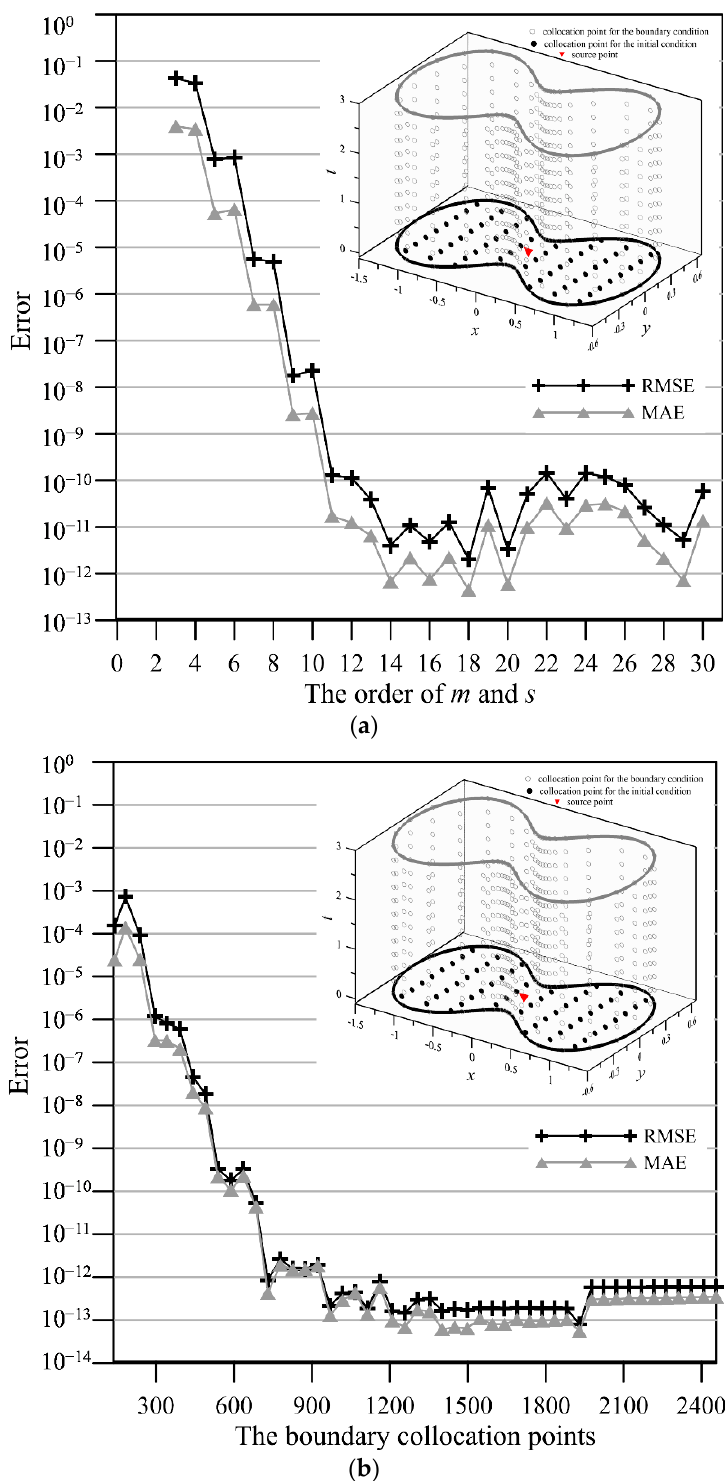
Figure 2. Convergence analysis: ( a ) The error versus the order; ( b ) The error versus the boundary points number.